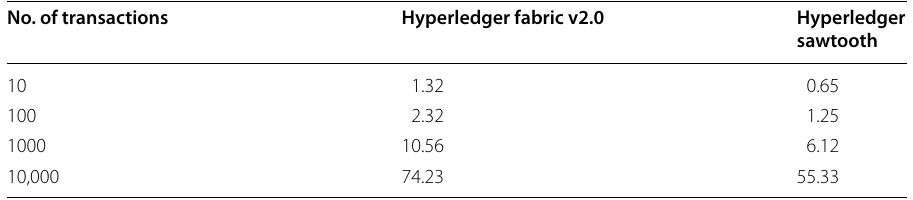
Table 4 Execution time—initialization process No. of transactions